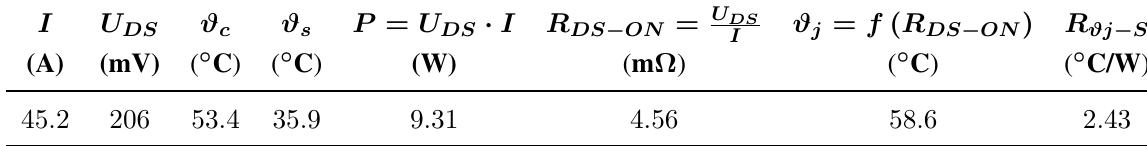
Table 3. Temperature characteristics’